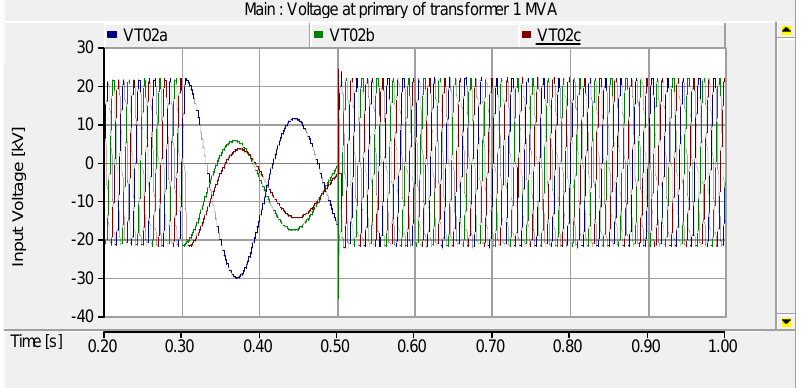
Figure 15. The three-phase circuit breaker disconnecting and connecting without the saturation transformer 1 MVA at the HV side.